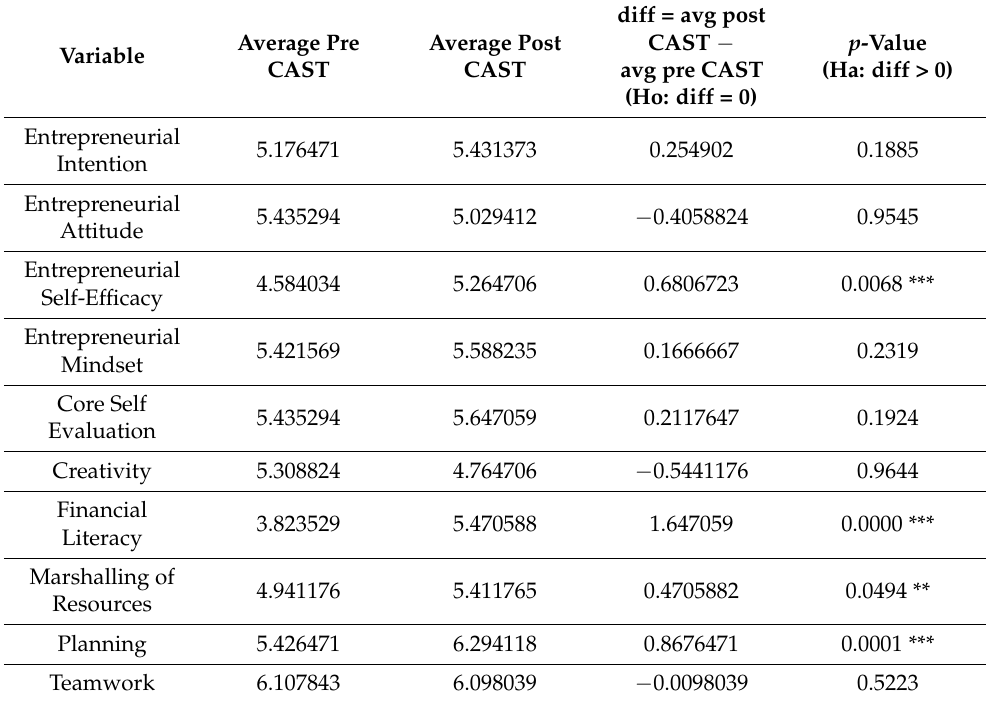
Table A1. Output of t -tests on entrepreneurial characteristics, pre- and post-course, of the whole